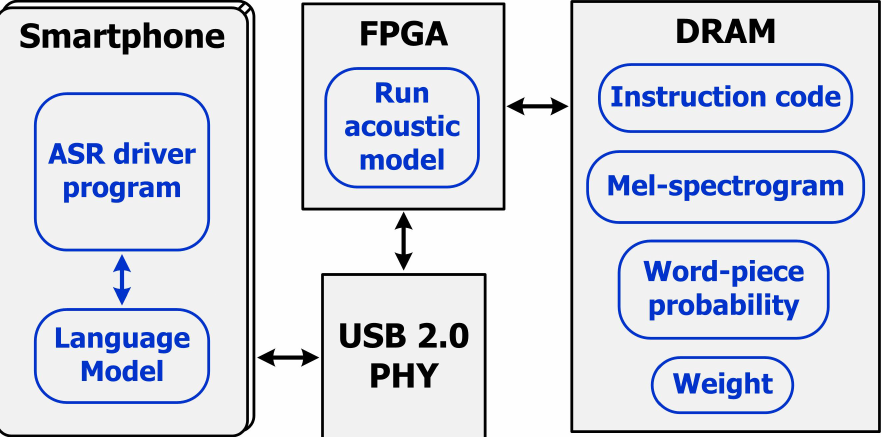
Figure 1. Proposed streaming ASR